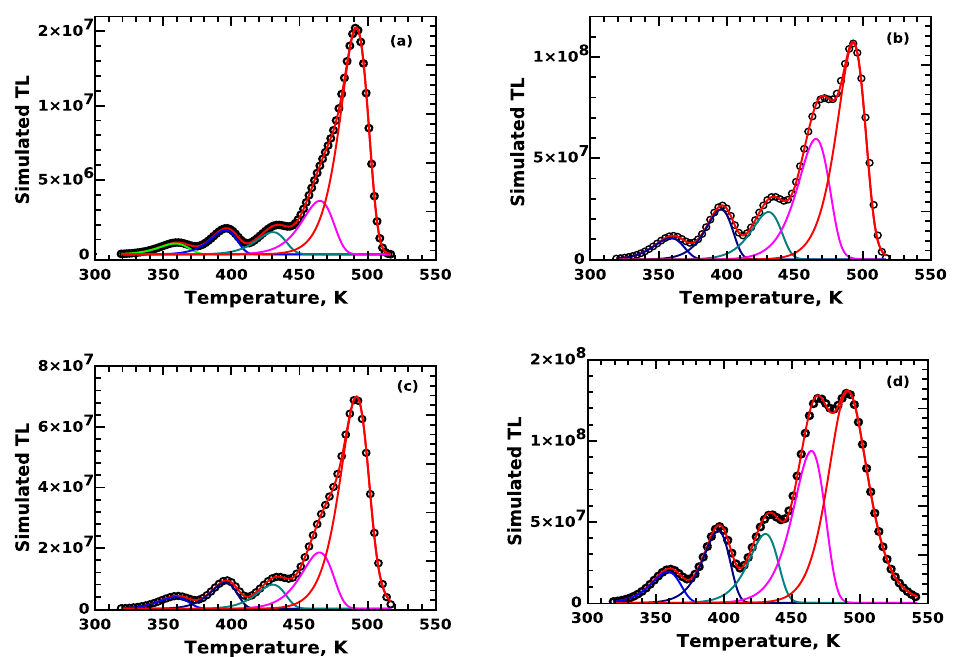
Figure 4. CGCD analysis results of the four REFERENCE glow curves used for